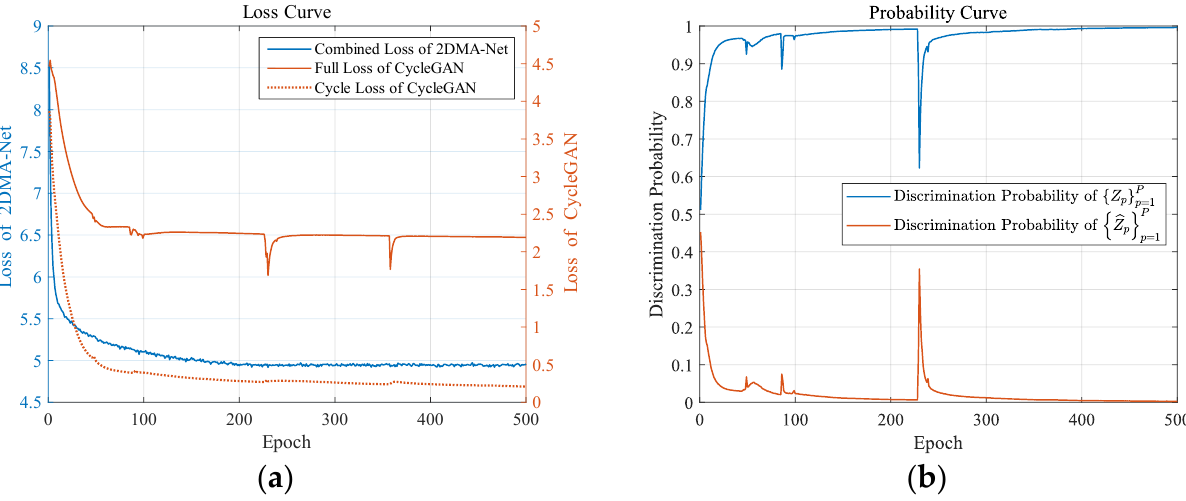
Figure 7. Network training convergence results: ( a ) training loss curves of 2DMA-Net and CycleGAN and ( b ) discrimination probability curves of the discriminator G Z .